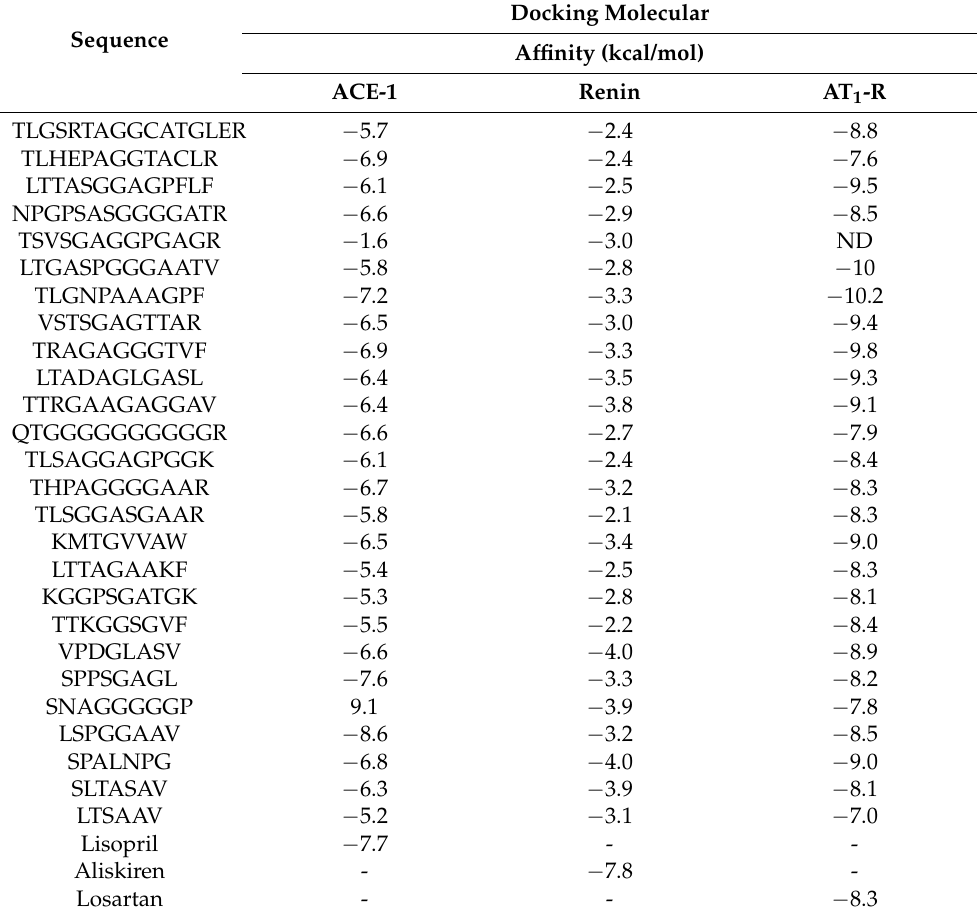
Table 3. Molecular docking of Criollo cocoa peptides on molecular targets related to hypertension. Docking Molecular Sequence Affinity (kcal/mol) ACE-1 Renin AT 1 -R